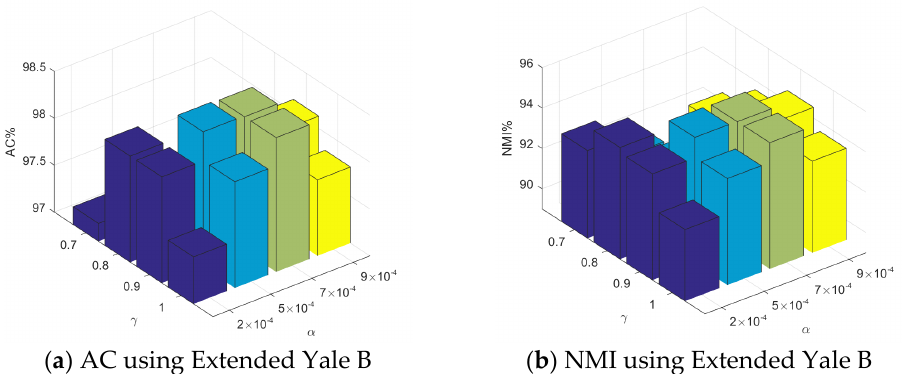
Figure 6. The AC and NMI values when using the Extended Yale B dataset.